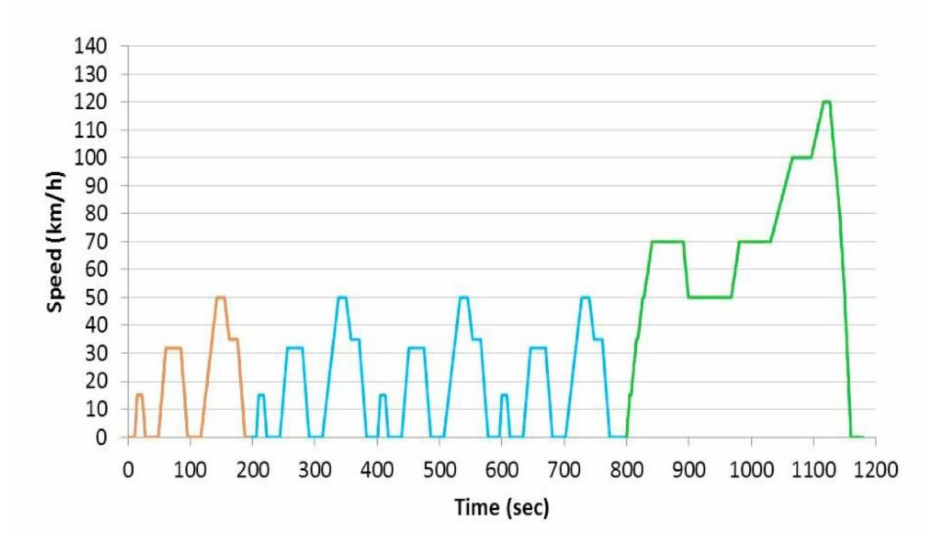
Figure 2. NEDC driving cycle with urban section module in red and extra-urban section in green C. Reprinted with permission from original publication: “What is the Most Representative Standard Driving Cycle to Estimate Diesel Emissions of a Light Commercial Vehicle?”, by Daniel Chindamo and Marco Gadola. IFAC-PapersOnLine, 51-5, pp. 73–78 (2018) [23] @2018 International Federation of Automatic Control (IFAC).